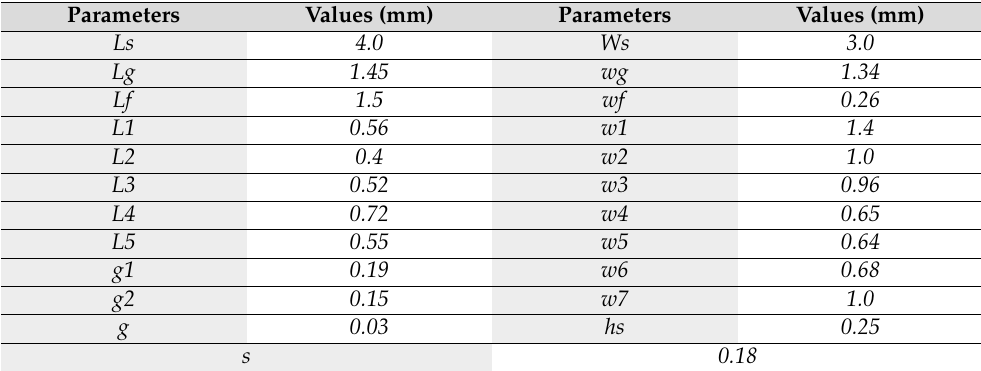
Figure 3. Microstrip feedline and an umbrella-shaped radiator comprise the antenna ’ s geometry; ( a ) front view, ( b ) back view, and ( c ) side view. Table 1. Optimized dimensions of the proposed design. Table 1. Optimized dimensions of the proposed design.